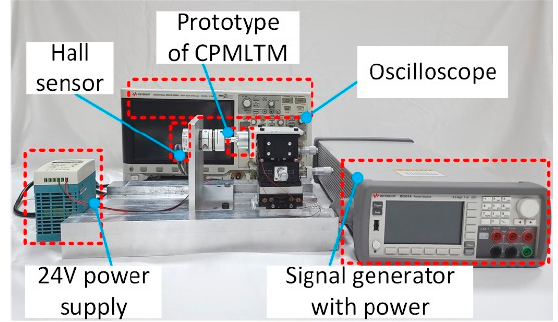
Figure 18. The static test rig.